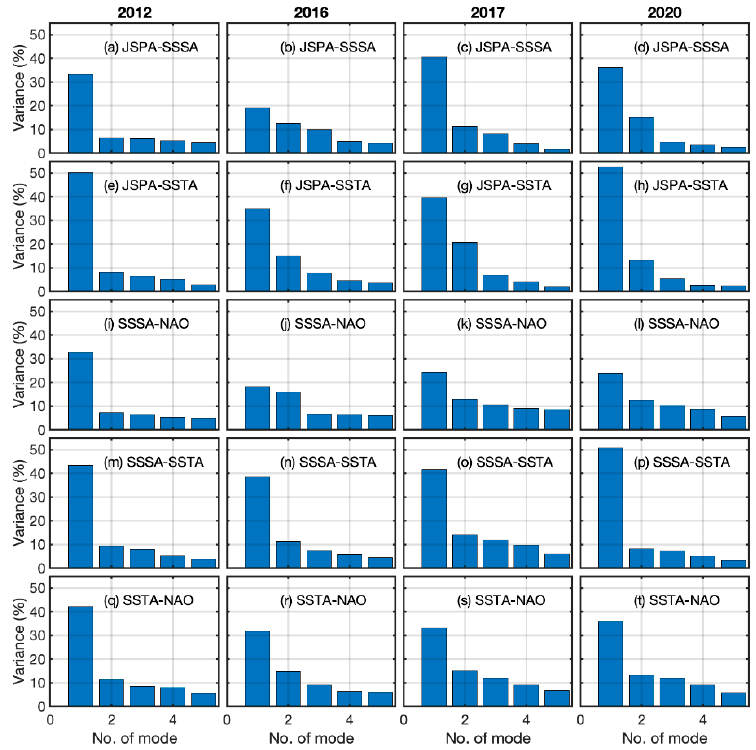
Figure 14. Bar graph of Variance of the Principal Components (PCs) calculated with eigenvectors from the trajectory matrix created by MSSA between the parameters JSPA, SSSA, SSTA, and NAO.